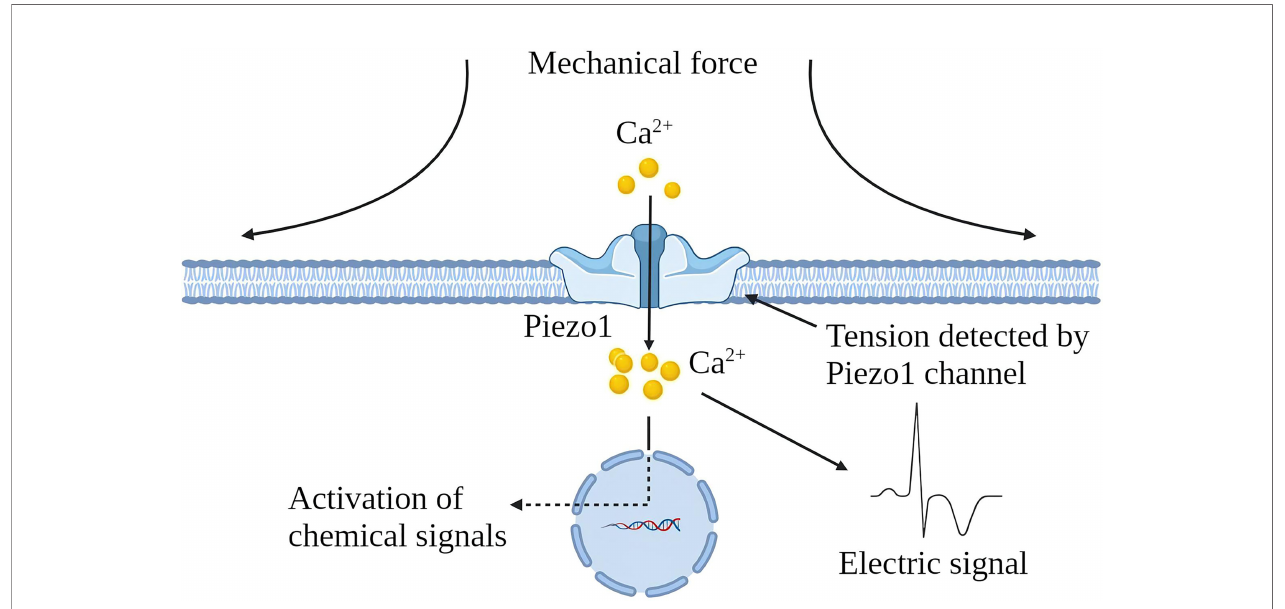
FIGURE 1 | Schematic diagram of Piezo1 channel activation by mechanical force. The Piezo1 channel is a trimeric structure located in the plasma membrane. The mechanical force exerted on the cell membrane causes the opening of the Piezo1 channel, leading to the in fl ux of extracellular Ca 2+ and transducing mechanical signals into electrical and chemical signals in the